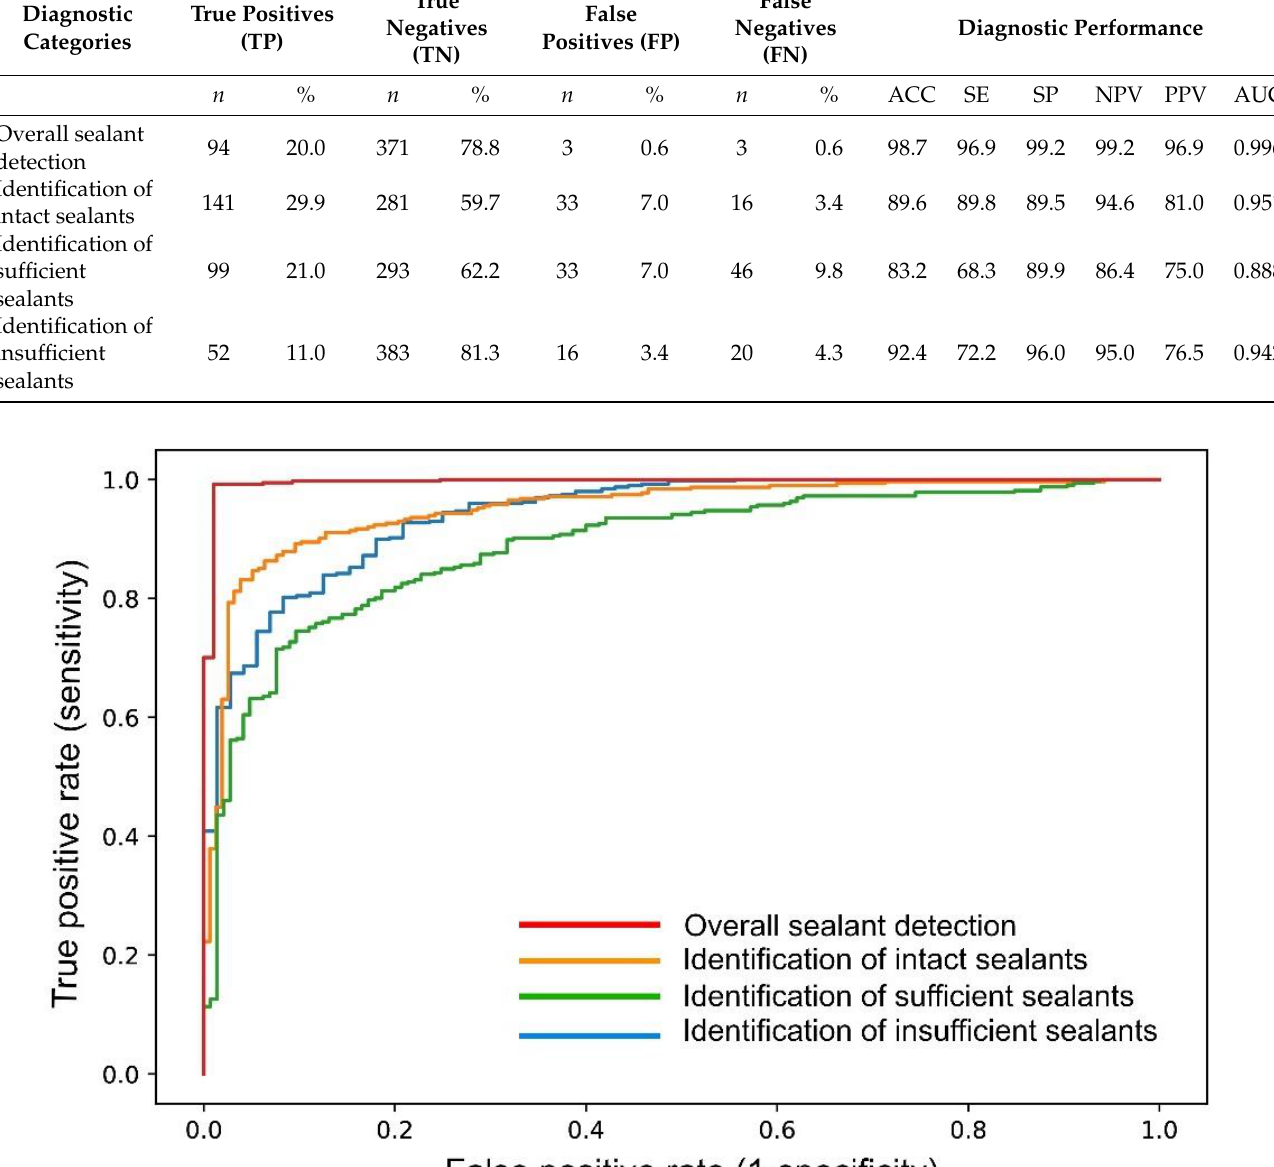
Figure 3. Confusion matrix showing the CNN classification performance for the test sample.